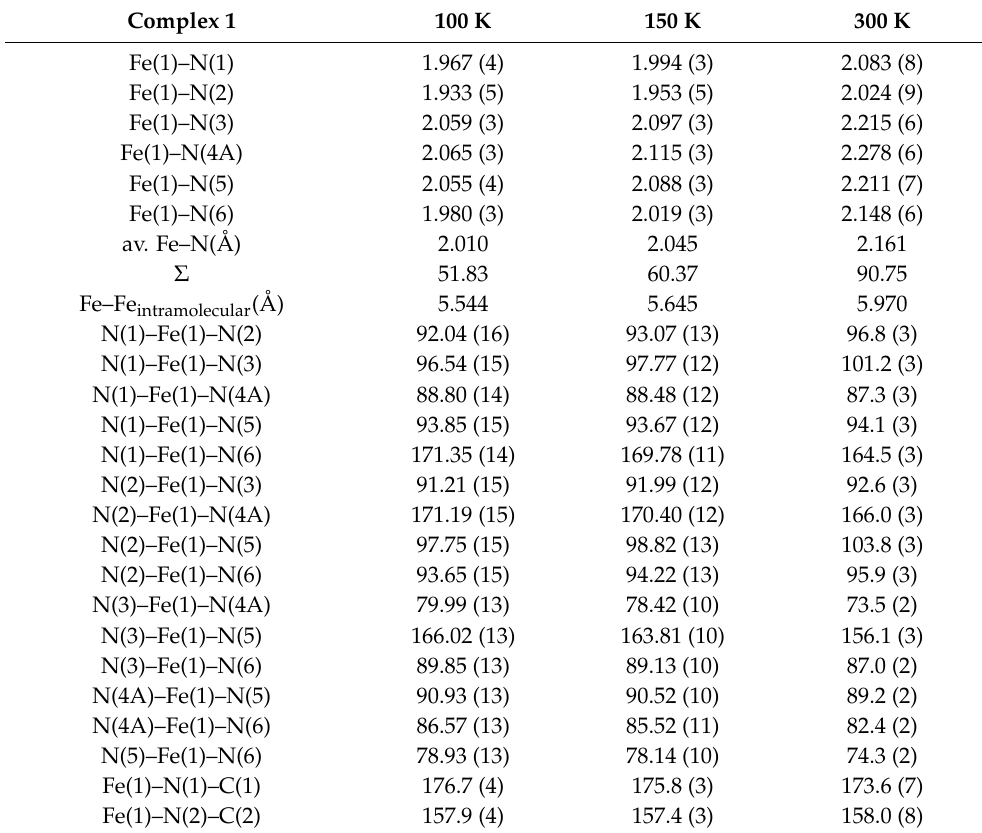
Table 1. Selected bond lengths [Å] and angles [ ◦ ] in the structures of complex 1 at various